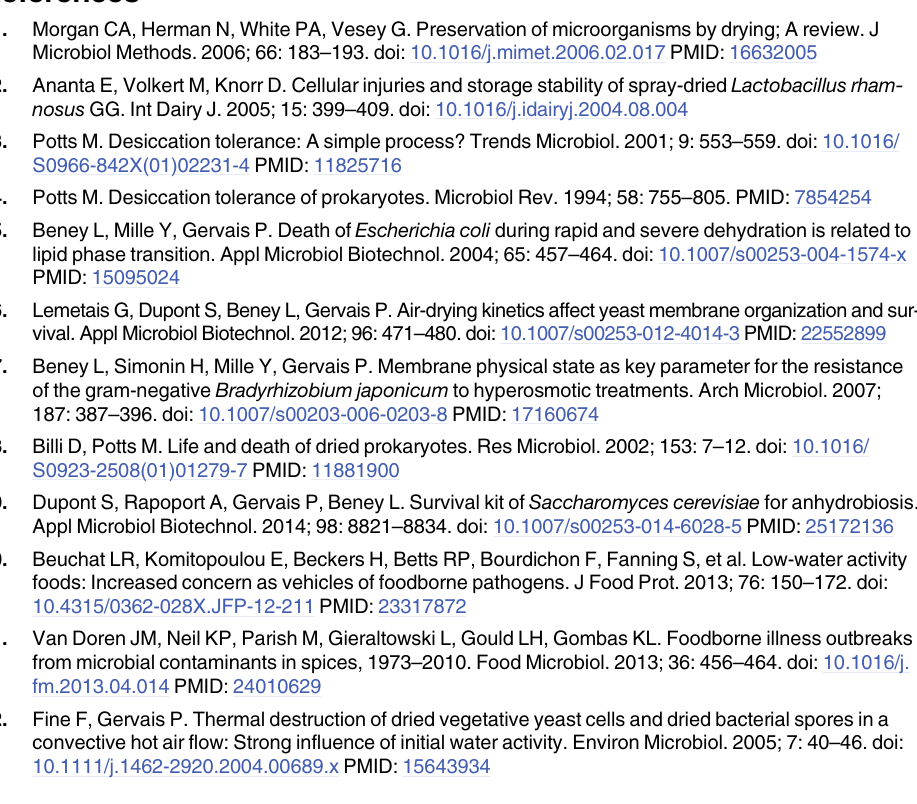
S1 Table. Logarithmic reduction of studied pathogens as function of instantaneous and rapid rehydration at four relative humidity levels (11%, 25%, 44% and 58% RH). S2 Table. Logarithmic reduction of studied pathogens as function of four rehydration mods (instantaneous, rapid, slow, and very slow) after drying at 11% RH for 90